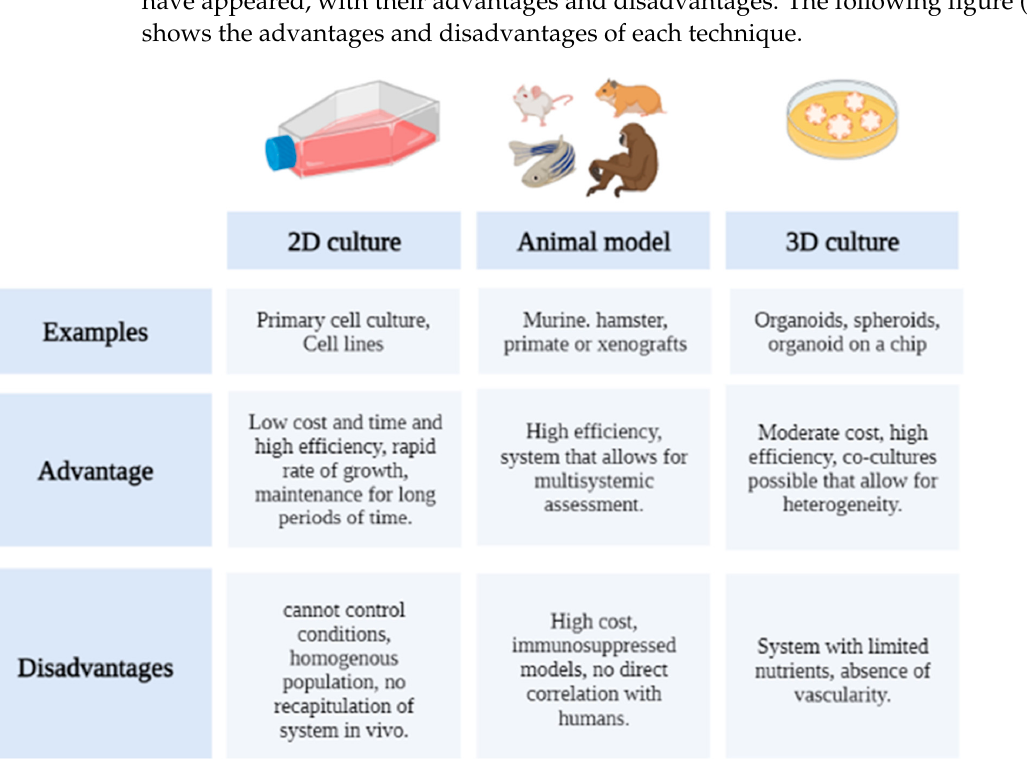
Figure 6. Advantages and disadvantages of commonly used systems for the evaluation of anticancer drugs. Created with